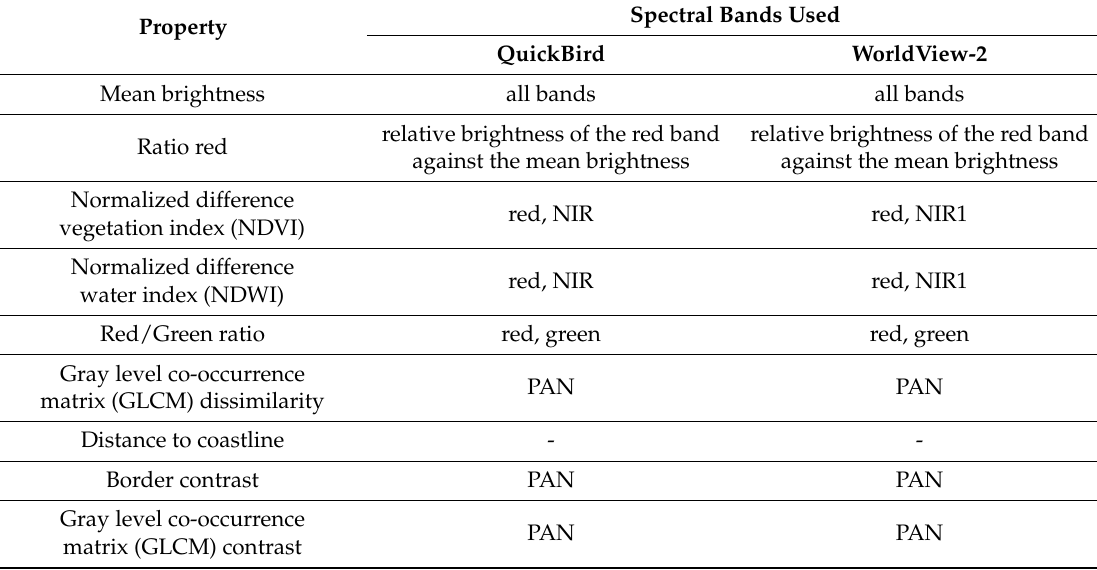
Table 2. Image object properties and corresponding spectral